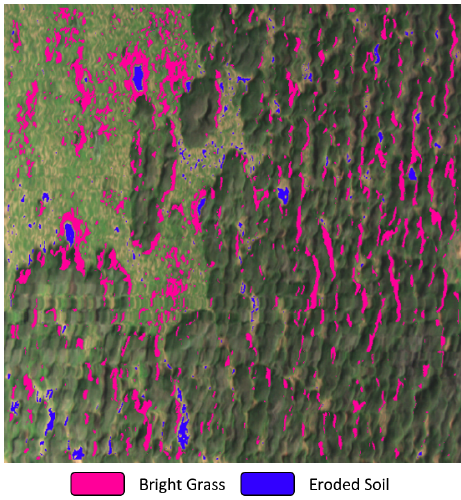
Figure 9. ROI with clustered termite mounds